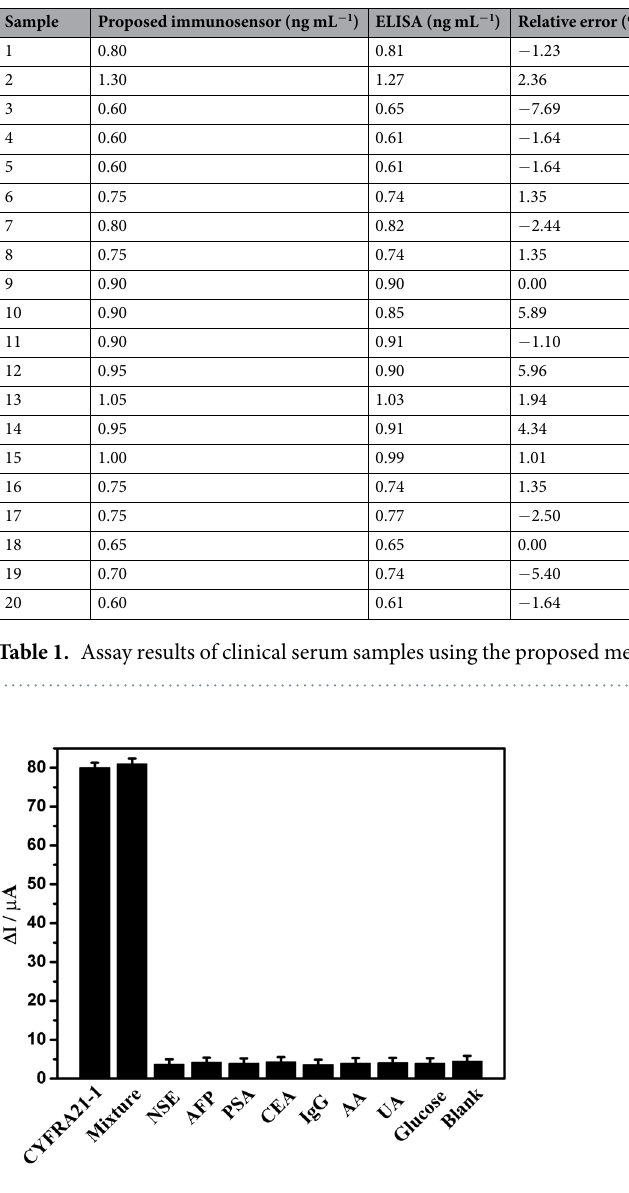
Figure 6. Anti-reference ability of the immunoassay (The error bars are standard deviations for n = 3). The concentrations of IgG, AA, UA, glucose, CEA, PSA, NSE and AFP were 10 ng mL − 1 . The mixture contains